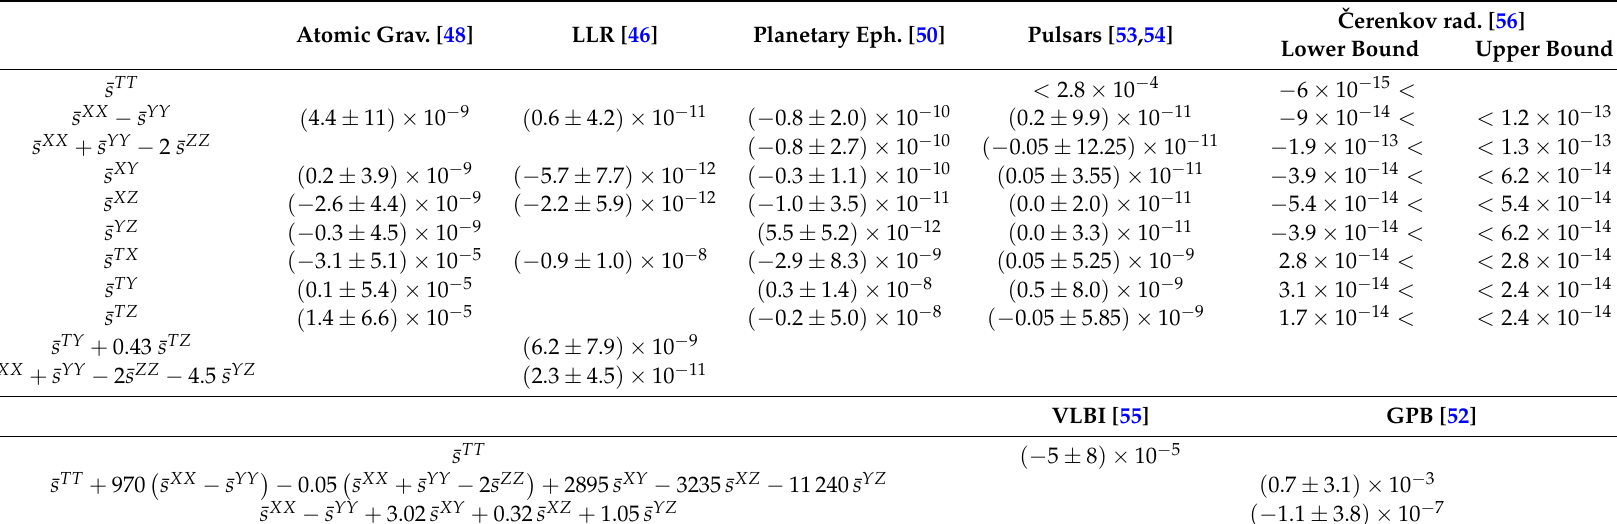
Table 8. Summary of all estimations of the ¯ s µν